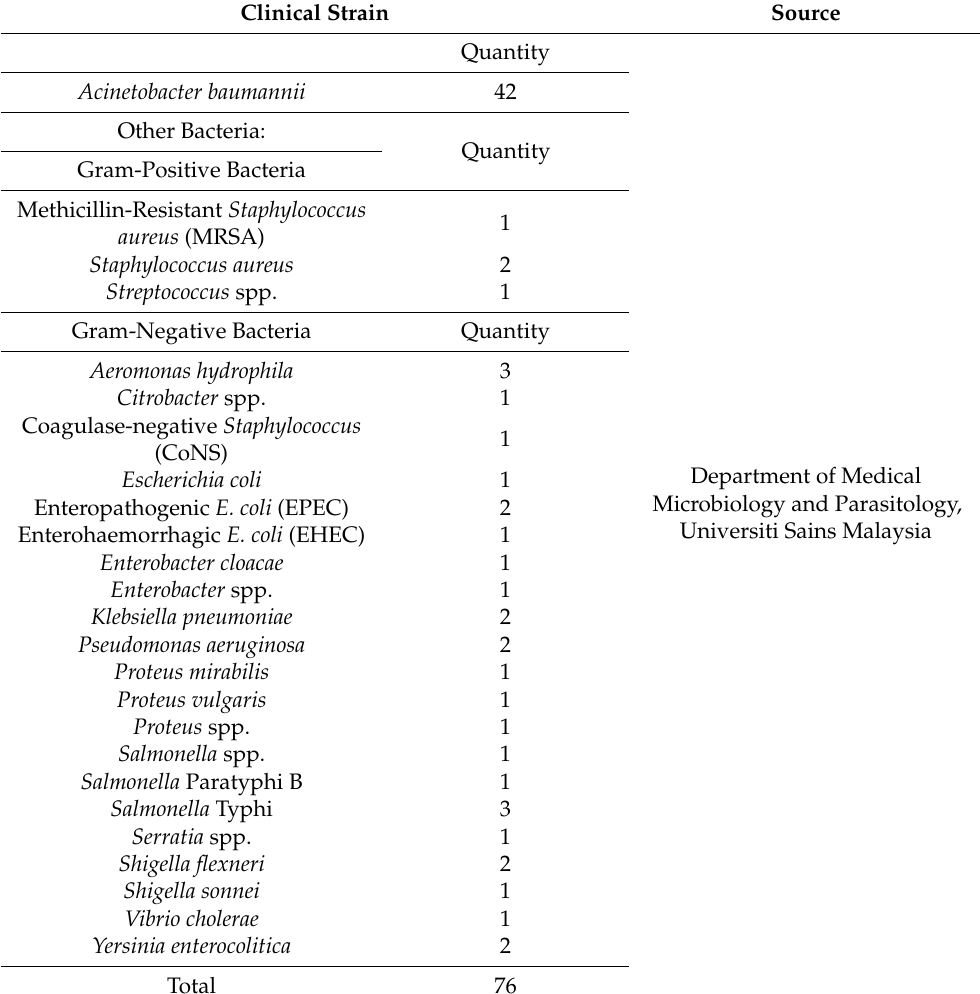
Table 2. List of clinical strains used in this